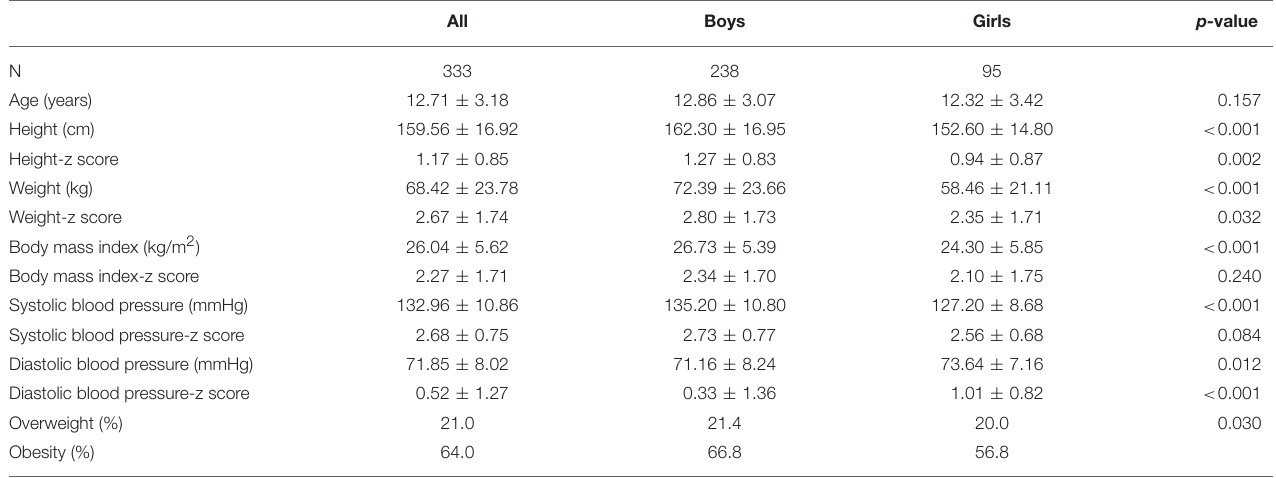
TABLE 1 | Characteristics of children who participated in the evaluation of target organ damage.